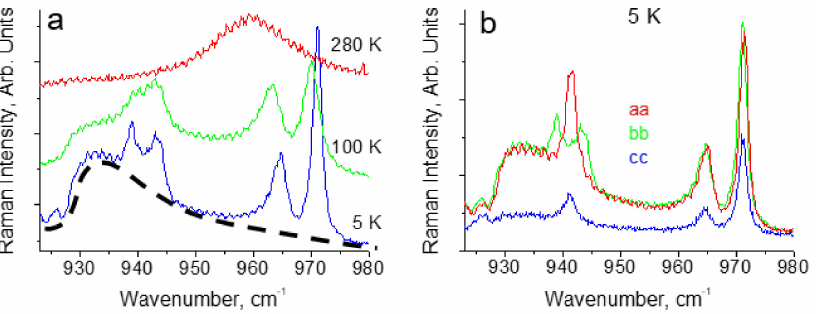
Figure 17. ( a , b ) Raman spectra of glycinium phosphite in the range of the hydrogen bond vibrations at different temperatures ( a ) and orientation of the polarization vector of the incident and scattered light relative to the crystallographic directions ( b